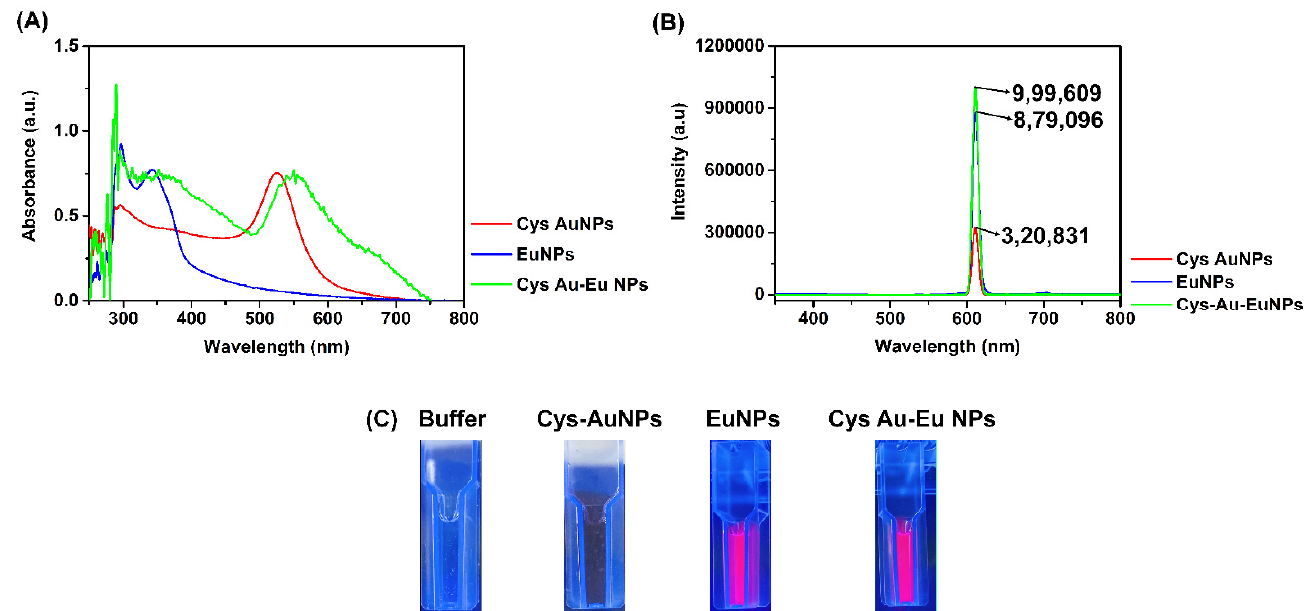
Figure 3. ( A ) UV-Visible Spectrum analysis and ( B ) fluorescence spectrum analysis of Cys AuNPs (Red line), EuNPs (Blue line), and Cys Au-Eu NPs (Green line); ( C ) Fluorescence images of buffer and nanoparticles are taken under UV exposure.